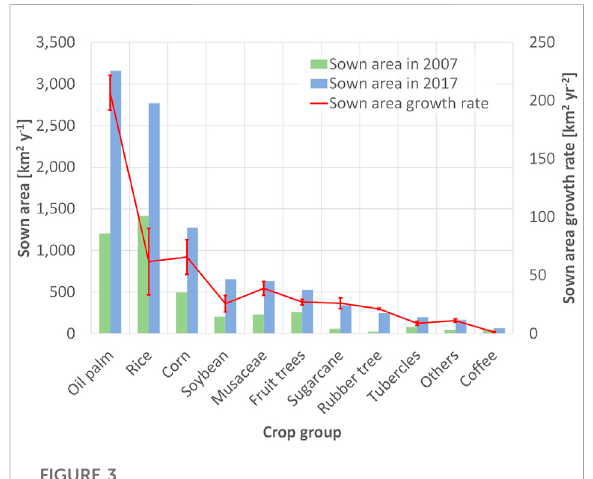
FIGURE 3 Sown areas and their growth rates in Colombia ’ s Orinoquia, broken down by crop group.